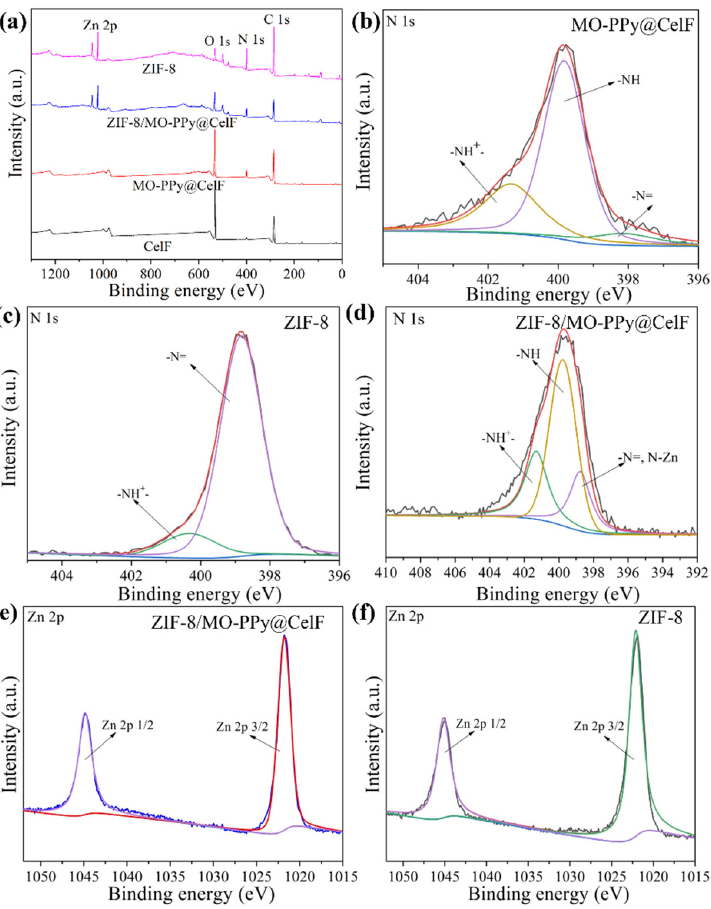
Figure 6. ( a ) XPS wide scan spectra of CelF, MO-PPy@CelF, ZIF-8 and ZIF-8/MO-PPy@CelF; ( b – d )